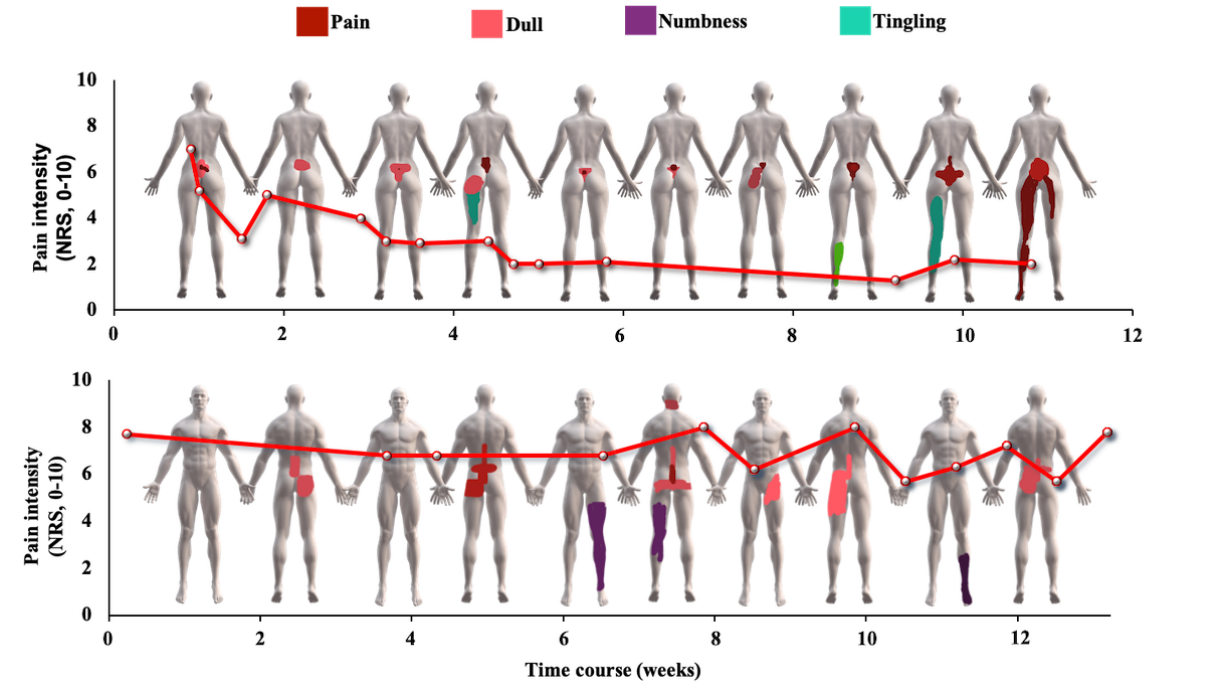
Figure 4. Examples of individual pain reports illustrating fluctuations in pain and discomfort intensity, total extent, and quality, spanning 12 weeks. The red line represents the weekly average current pain intensity rating. The pain drawings were selected every second week to capture the general overview of the changes in pain and discomfort quality descriptors selection and the fluctuations in pain and discomfort extent over the 12 weeks. NRS: numerical rating